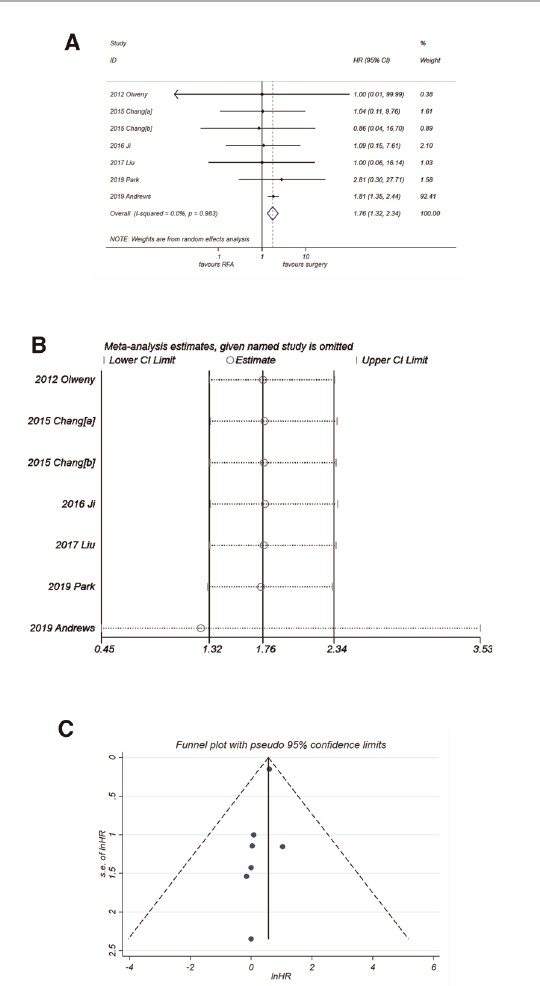
FIGURE 5 Comparison of CSS of RFA vs. PN. ( A ) The forest plot shows the HR of CSS of RFA vs. PN. HR>1 indicates that RFA has higher risk for CSS. ( B ) Sensitivity analysis was performed by omitting one study at each analysis. The result of each analysis is also presented as the forest plot. ( C ) The funnel plot was used to detect publication bias. CSS, cancer-speci fi c survival; HR, hazard ratio; PN, partial nephrectomy; RFA, radiofrequency ablation.